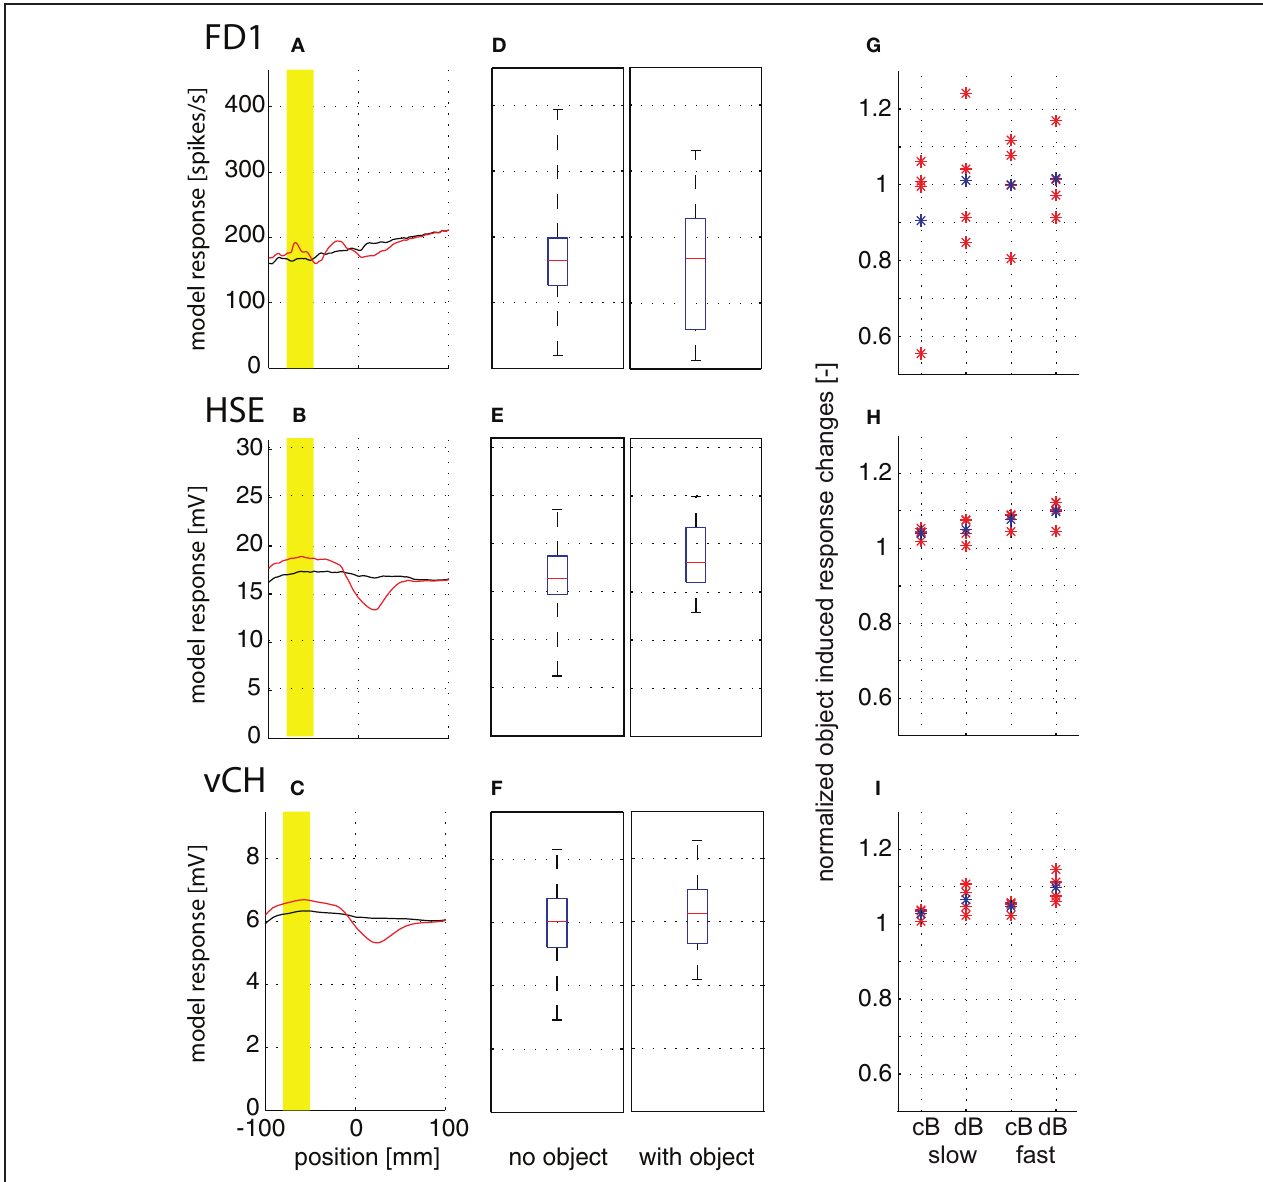
FIGURE 7 | Object-induced response changes. Responses to straight flight sequences. The fly crossed the virtual flight arena parallel to and at equal distance from the side walls and the floor. A vertical cylindrical object (4mm) was placed at a small distance from the flight trajectory. (A–C) Position-dependent response traces of FD1 (A) , HSE (B) , and vCH (C) while passing the object at 1 m/s in the small arena (cB) for one texture condition. Response traces without object are plotted in black, and those with object, in red. Position 0 is defined as the fly’s position on the trajectory with the object at 90 ◦ in the lateral visual field. The yellow bar marks a flight interval of 30mm length where the moves were through the most sensitive part of the cells’ receptive field. (D–F) The median, quartiles, and range of